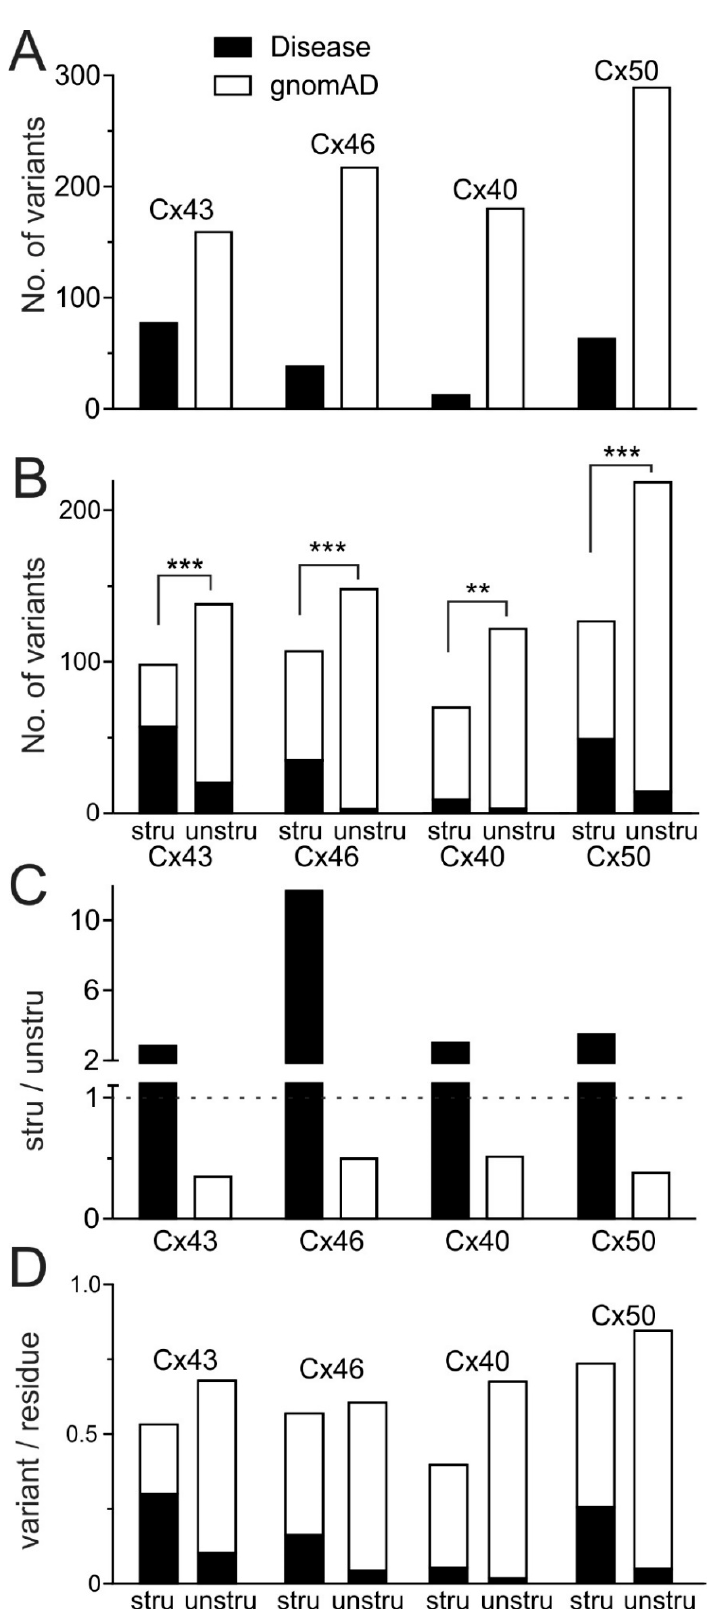
Figure 5. Disease-linked and gnomAD-linked missense variants showed unique pattern of distribu- tion. ( A ) Total numbers of unique missense variants are plotted for each of the selected connexins for disease-linked (black bars) and gnomAD-linked (open bars). ( B ) The numbers of unique